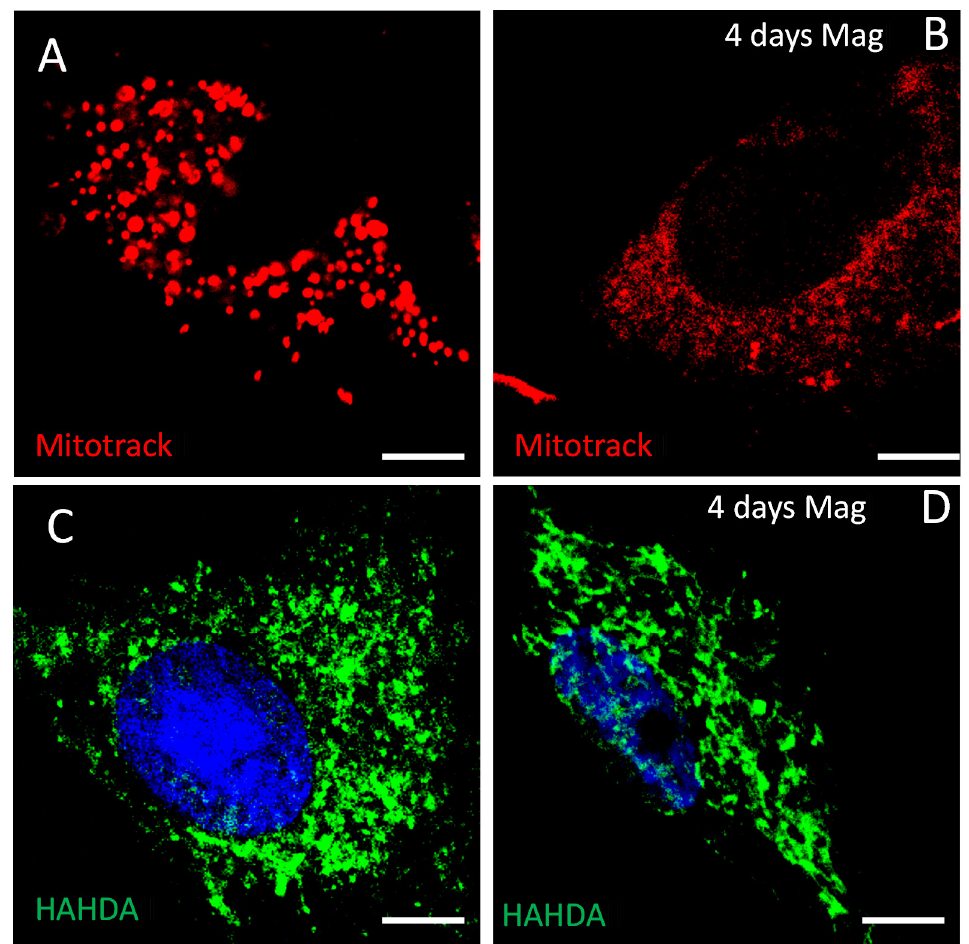
Figure 5. Confocal laser scanning microscopy analysis on PDLSCs MAG at day 4. ( A , B ) Images with MitoTracker Red fluorescence (red) of PDLSCs (upper left) and PDLSCs MAG (upper right). ( C , D ) PDLSCs immunostained with the antibody HAHDA (green) without (lower left) and with (lower right) magnetic stimulation. Scale bar: 100 μ m.